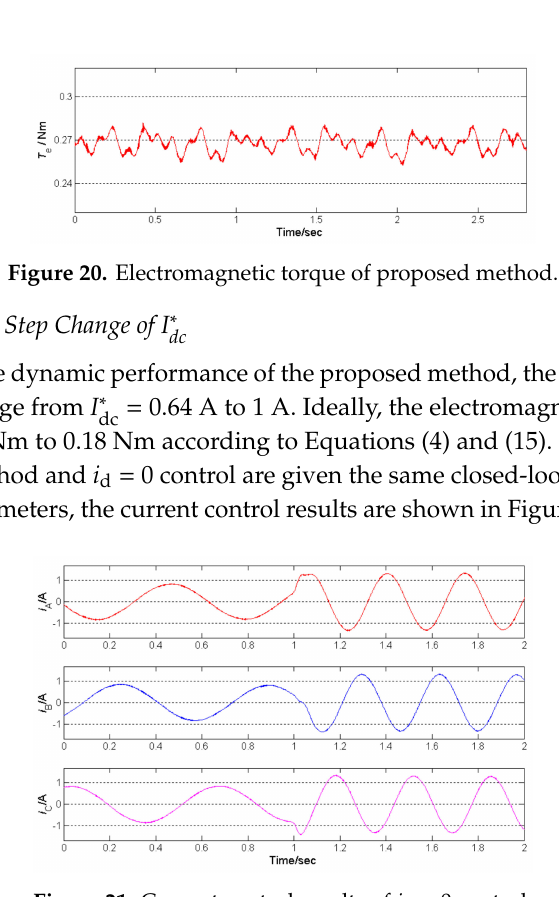
Figure 21. Current control results of i d = 0 control.